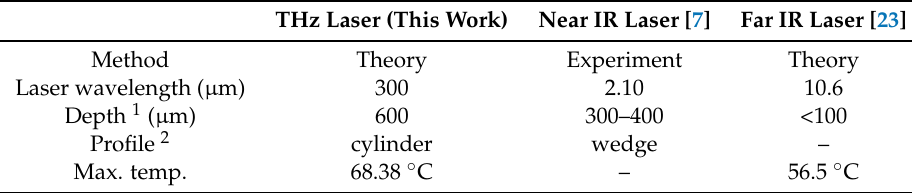
Table 2. Comparison of heating cornea with THz and typical infrared (IR)